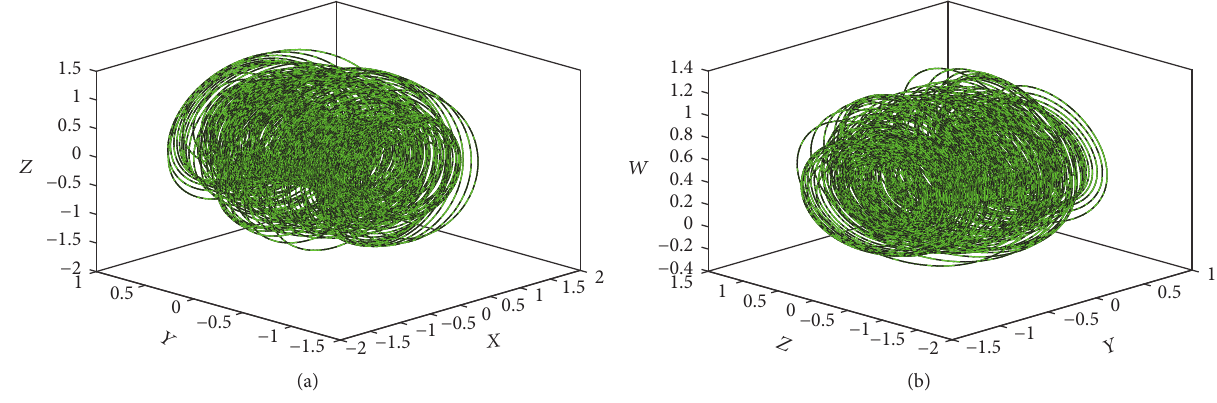
Figure 6: 3D state portrait of the FOMNE system ( 𝑋𝑌𝑍 plane; 𝑌𝑍𝑊